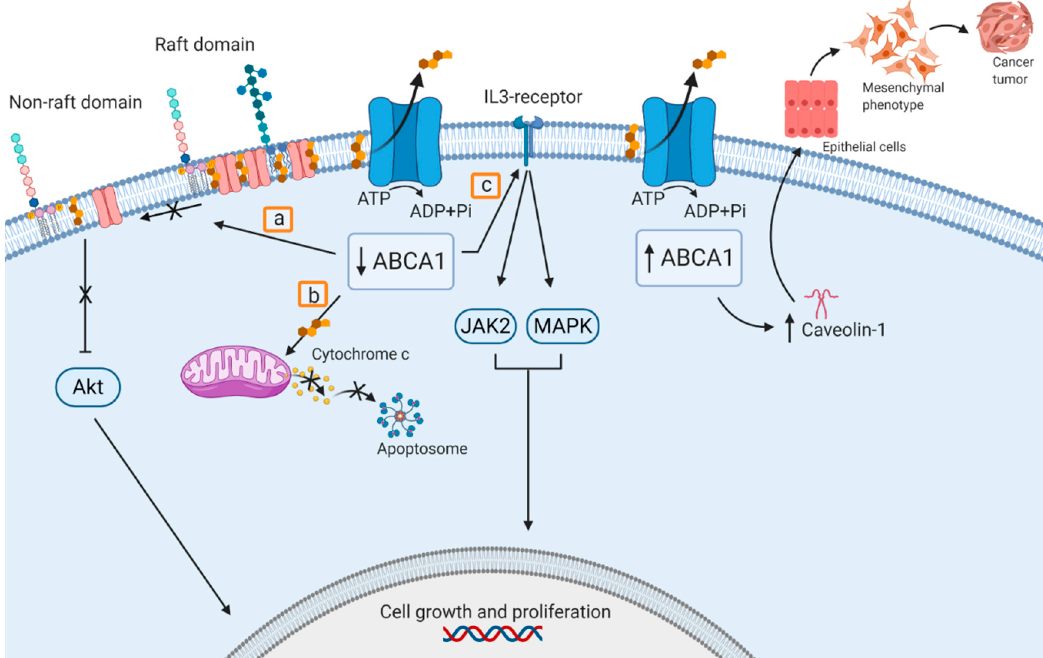
Figure 3. Proposed pathways of ABCA1 involvement in cancer. Downregulation of ABCA1 promotes cell growth and proliferation. a: ABCA1 downregulation avoids raft domain disruption and Akt pathway activation; b: ABCA1 downregulation causes cholesterol accumulation in the mitochondrial membrane inhibiting cytochrome c release and apoptosome formation; and c: ABCA1 downregulation activates the IL3-receptor, activating Janus kinase 2 (JAK2) and mitogen-activated protein kinase (MAPK) pathways. Upregulation of ABCA1 stabilizes caveolin-1 promoting epithelial-mesenchymal transition, and thus cell migration an invasion.